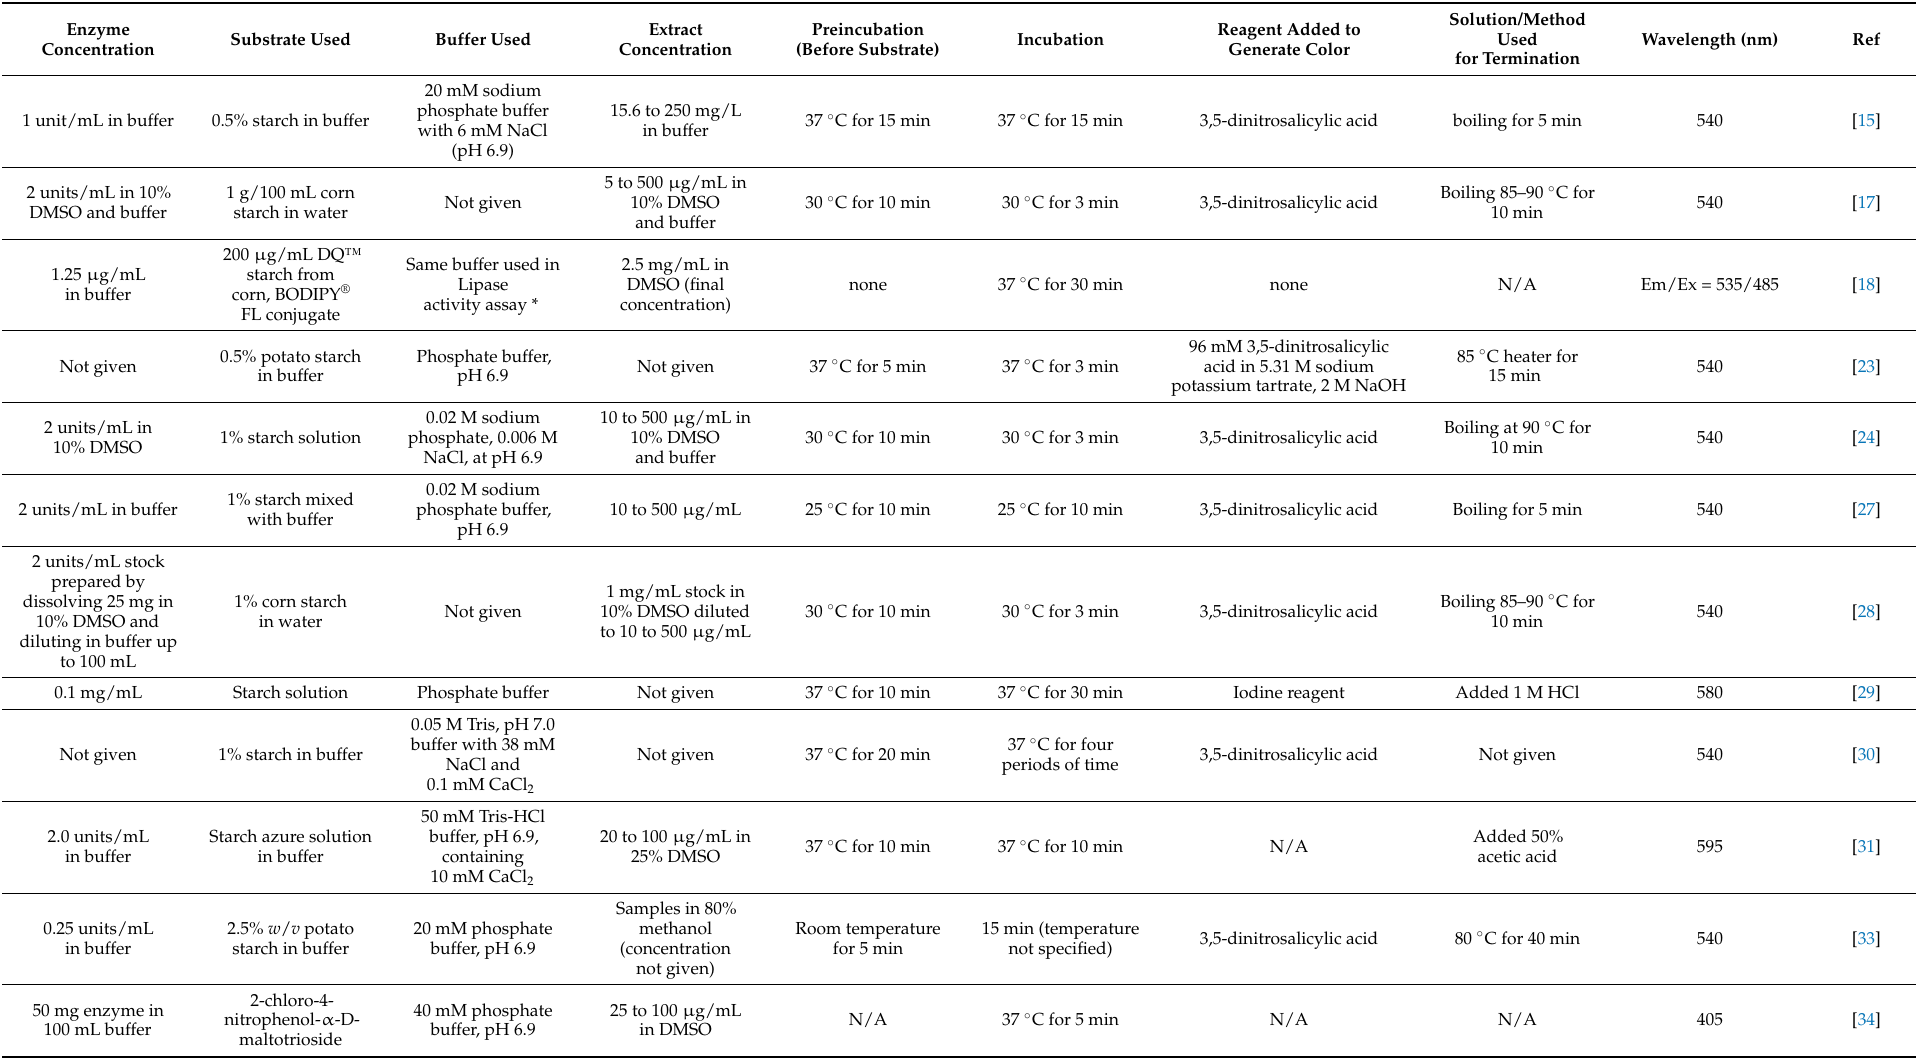
Table 5. Conditions used during the screening for α -amylase inhibitors using plant